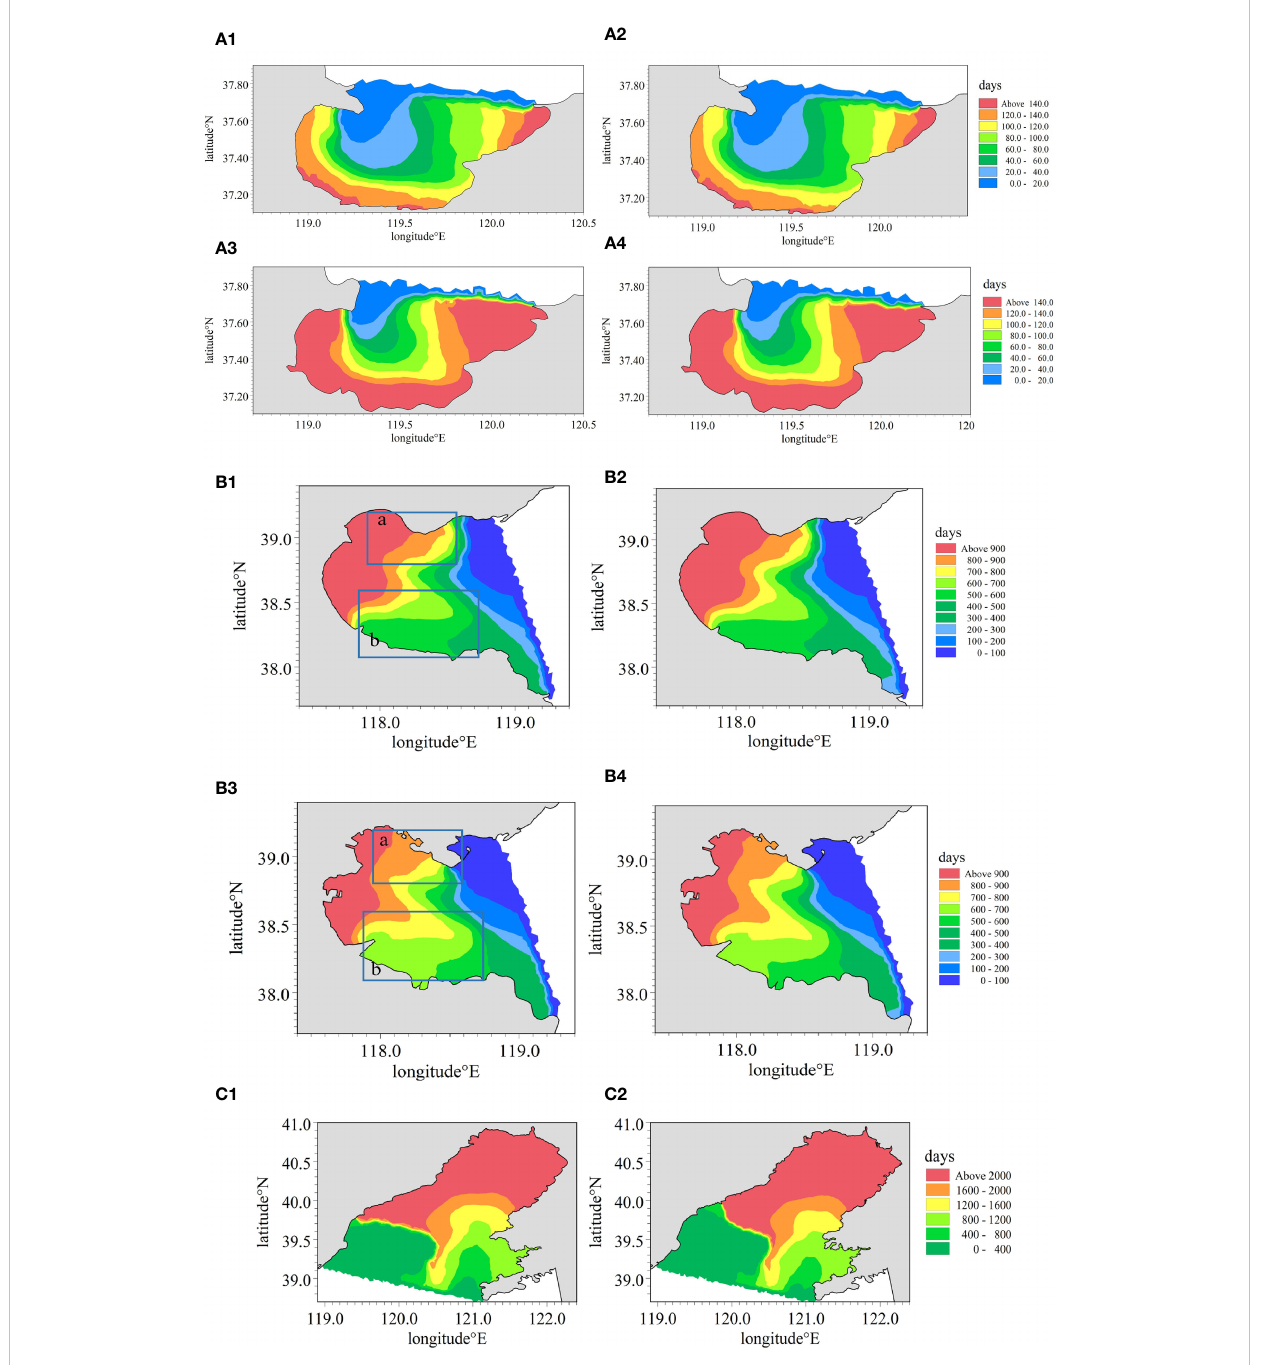
FIGURE 7 Local residence time (A1) Bohai Bay in 1999; (A2) Bohai Bay under the in fl uence of with runoff in 1999; (A3) Bohai Bay in 2019; (A4) Bohai Bay with runoff in 2019; (B1) Laizhou Bay in 1999; (B2) Laizhou Bay with runoff in 1999; (B3) Laizhou Bay in 2019; (B4) Laizhou Bay with runoff in 2019; (C1) Liaodong Bay in 1999; (C2) Liaodong Bay in